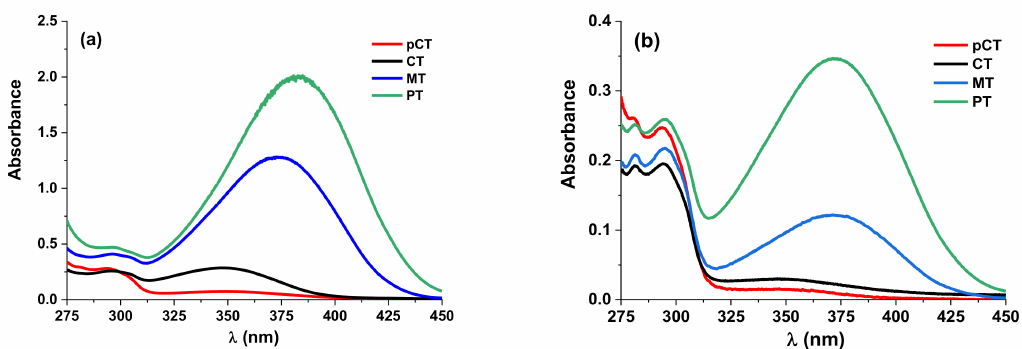
Figure 6. Photopolymerization profiles (double bond conversion vs. time) of TMPTA obtained in laminate in the presence of diverse equivalent triazine moiety concentration ( a ) pCT and ( b ) CT upon exposure to LED at 410 nm.